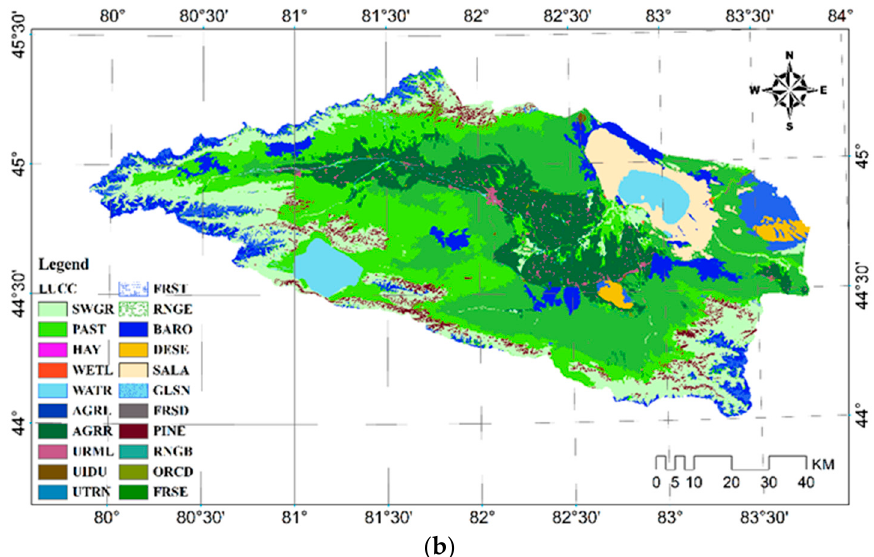
Figure 2. ( a ) Soil classification and ( b ) Land usage distribution.Remarks: SWGR: Slender Wheat grass;